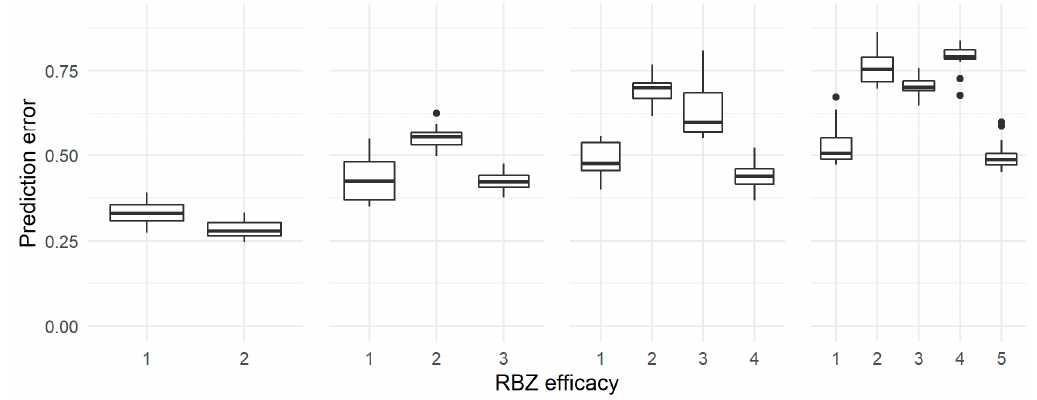
Figure 6. Cross-validation results for the different output states based on the 72 complete BNs with all nodes. Higher state numbers correspond to more effective RBZ.